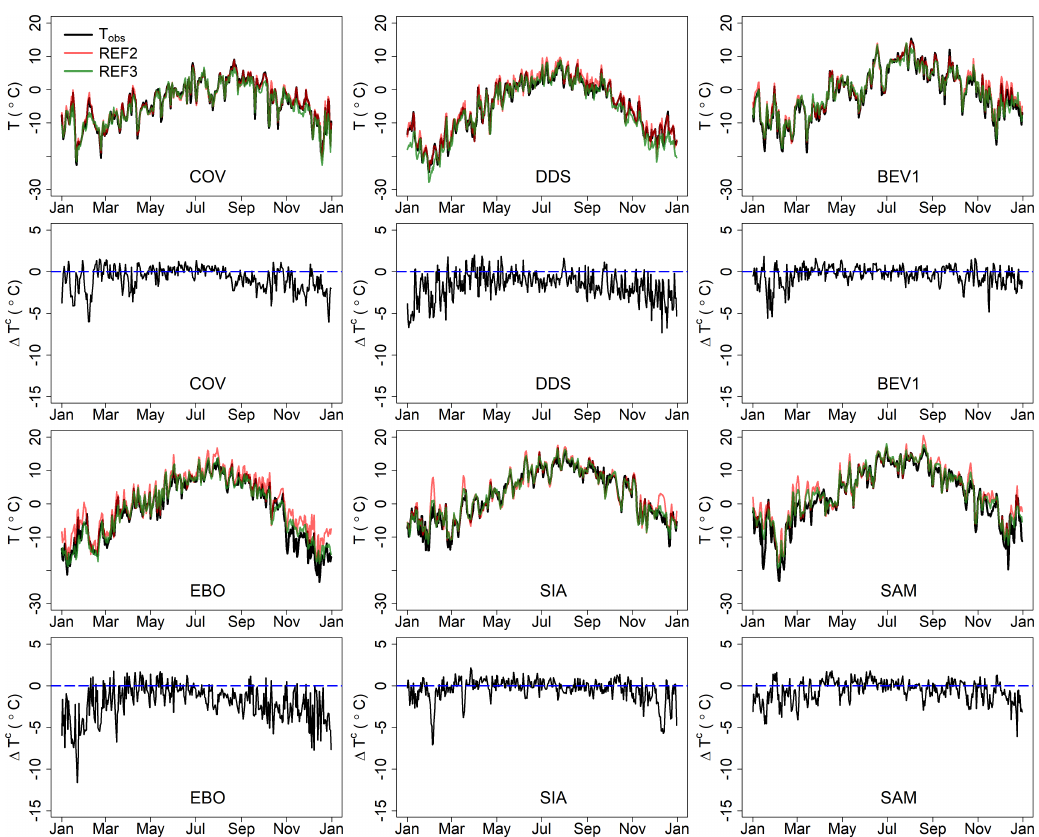
Figure 6. Detailed time series of (cid:49)T c , T obs , REF2 and REF3 at the selected stations from different geomorphometric positions. Table 3. Comparison of observations against reference methods of REF2 and REF3. Location REF2